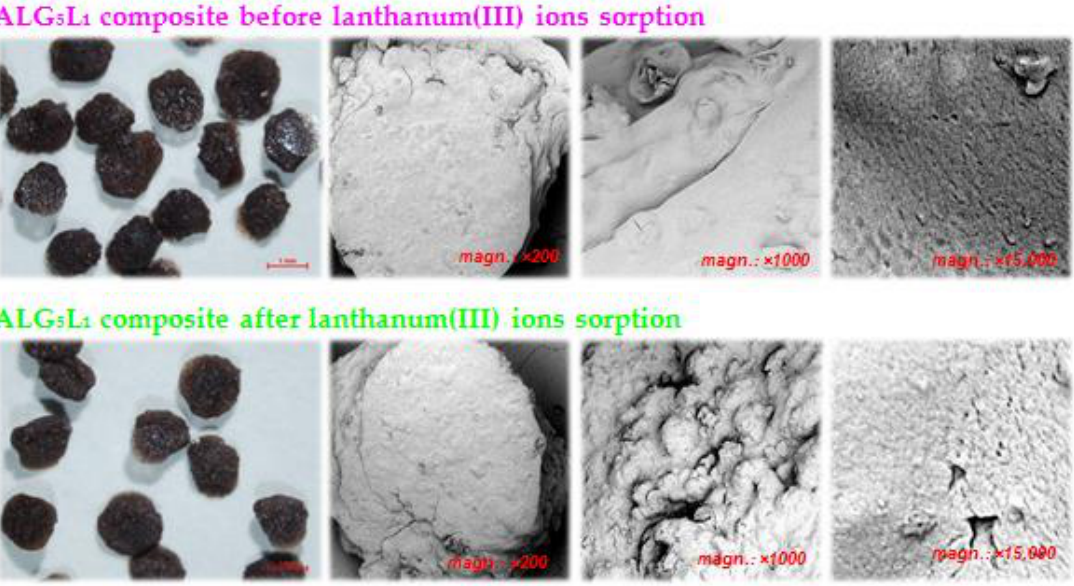
Figure 2. OM and SEM images of ALG 5 L 1 composite before and after La(III) ions sorption at a magnification of 200, 1000, and 15,000×.